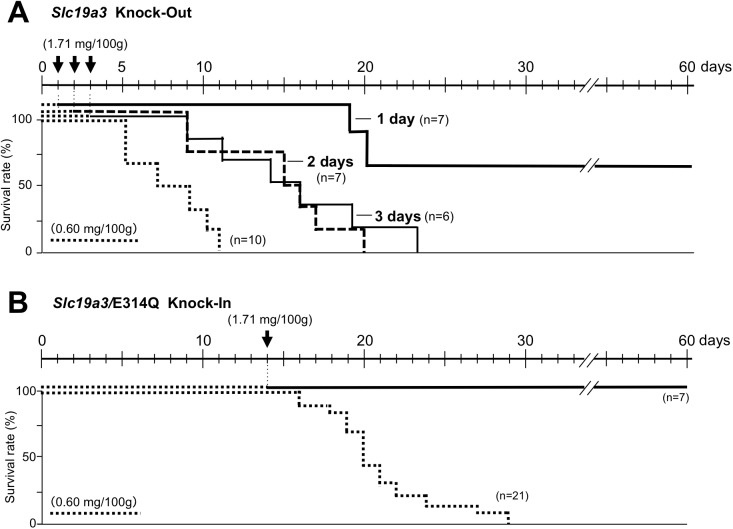
Survival rates of homozygous Slc19a3 KO and KI mice fed with a conventional diet after thiamine restriction.A. Thirty homozygous KO mice were fed with a thiamine-restricted diet (thiamine 0.60 mg/100 g food) (dotted line). One (thick line), 2 (broken line), and 3 days (thin line) later, the diet of 7, 7, and 6 mice was reverted to a conventional diet, respectively. B. Twenty-eight homozygous KI mice were fed with thiamine 0.60 mg/100 g food (dotted line). After 14 days of a thiamine-restricted diet (thiamine 0.60 mg/100 g food), the diet of 7 homozygous KI mice was reverted to a conventional diet (1.71 mg/100 g food) (thick line).